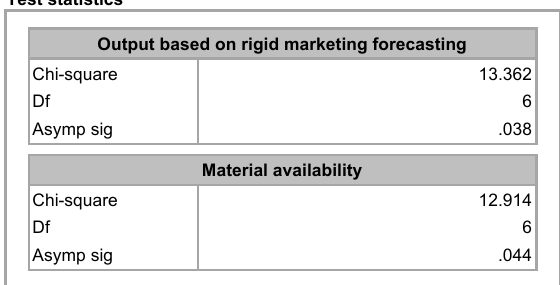
Hypothesis 2: Kruskal-Wallis results